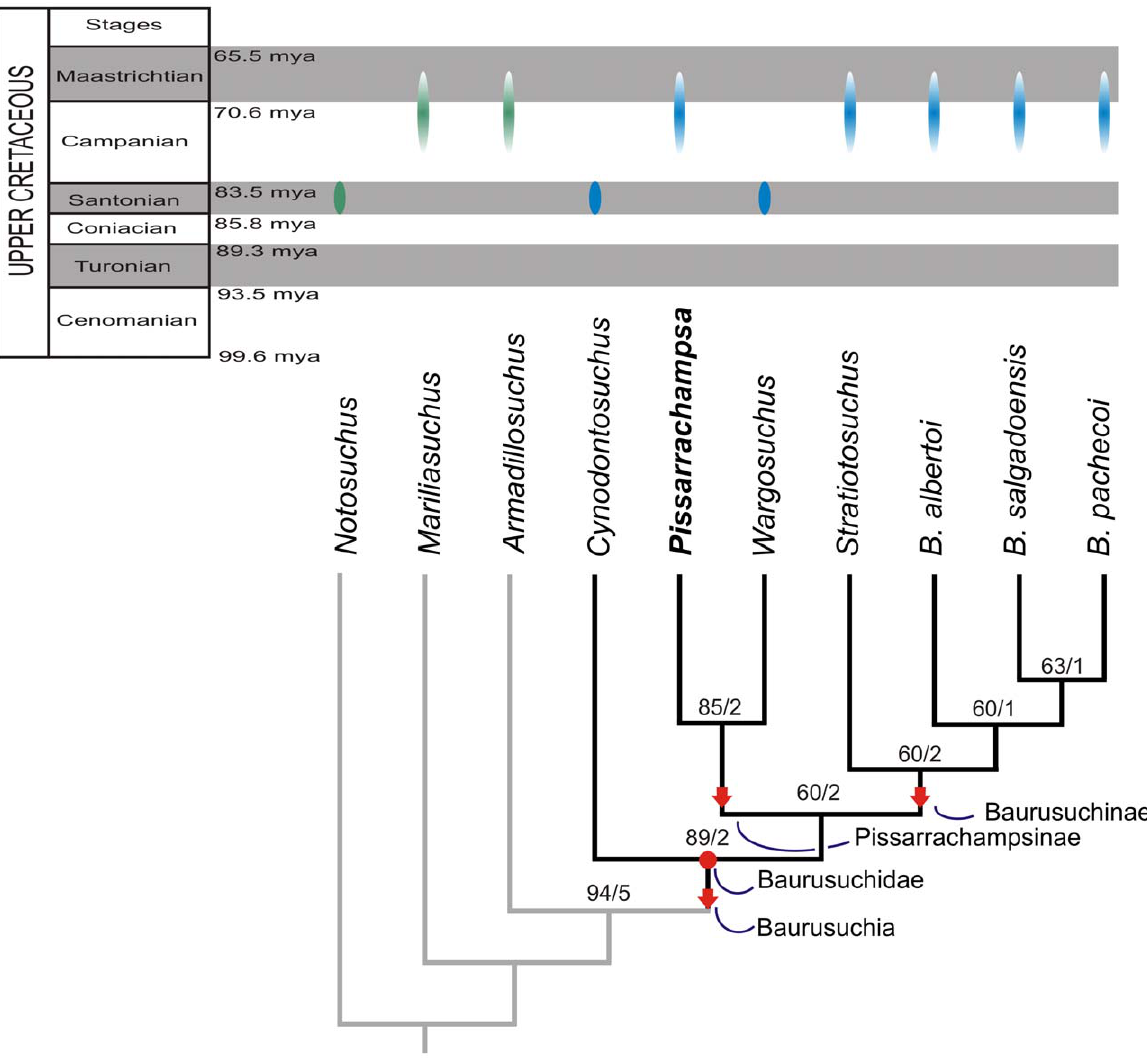
Figure 17. Phylogenetic relationships of Baurusuchidae depicting the position of Pissarrachampsasera . The single most parsimonious tree (total length = 80 steps; consistency index = 0.83; retention index = 0.84) recovered after maximum parsimony analysis using TNT. The bootstrap (50% cut) and decay values are shown above the clades. Ages from [21,105] for Argentinean taxa and [101,102] for Brazilian taxa. Arrows assigned to stem-based taxa, and circle for node based.